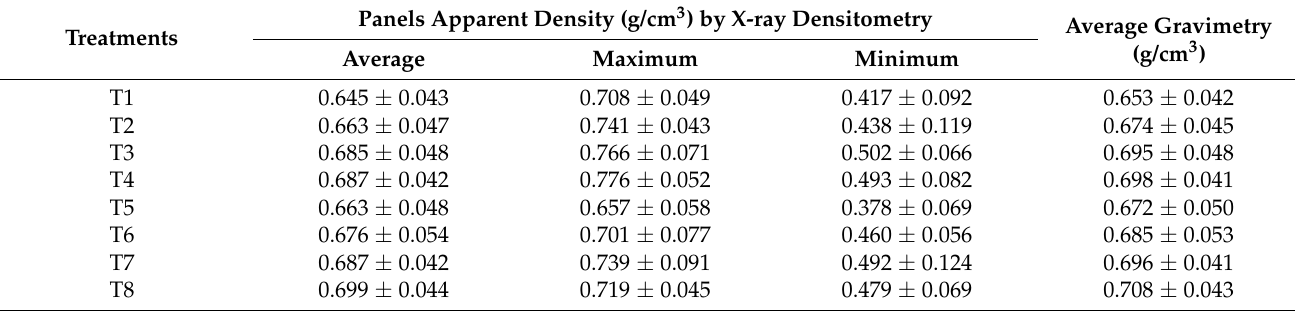
Table 6. Apparent densities of panels by X-Ray